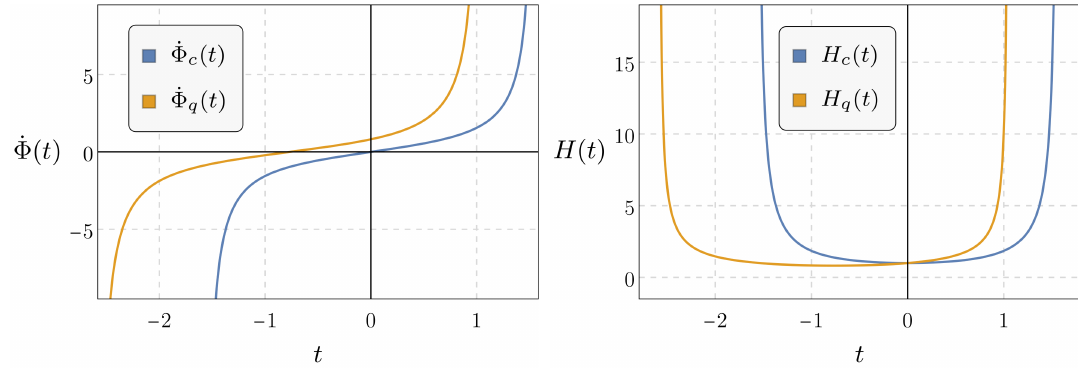
Figure 9 . Scaling of the first time derivatives of the dilaton Φ( t ) (left panel) and of the Hubble parameter H ( t ) (right panel). All quantities are in units of Λ . The “classical” (blue line) and quantum-corrected (orange line) curves share a qualitatively similar shape. The quantum-corrected curve, which arises from the effective action in eq. (4.36), also appears to be shifted in time with respect to the classical